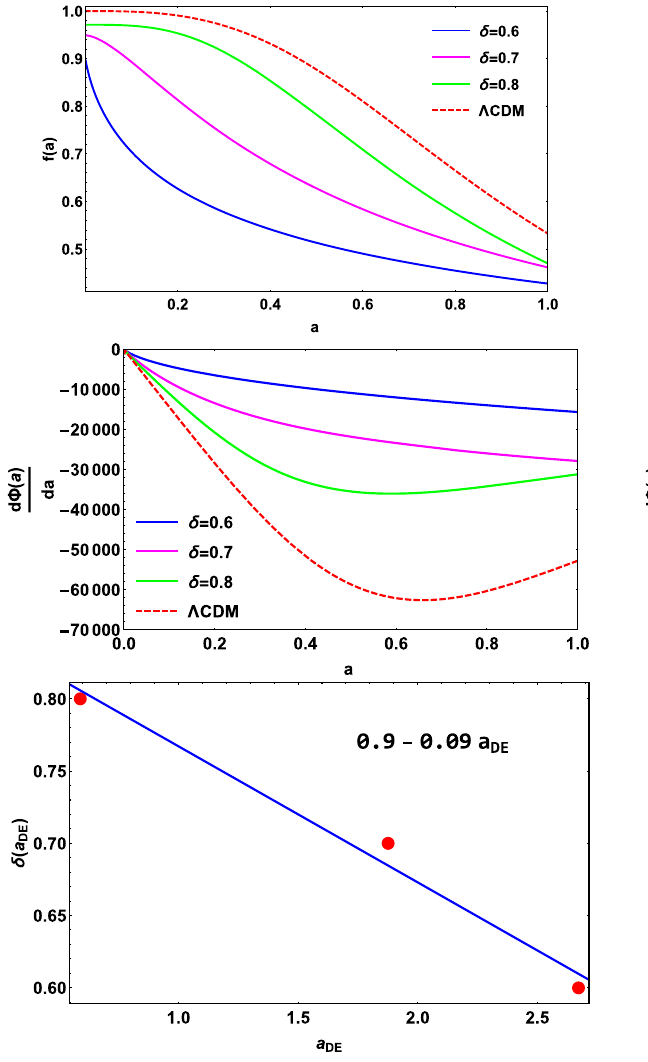
Fig. 4 Topleftpanelshowstheevolutionofgrowthrate f ( a ) ,topright panel shows the rate of change of configurational entropy ( d Φ( a ) ), and da the lower panel shows the best fit relation between the non-additivity parameter δ and the scale factor a DE at which d Φ( a ) attains a minima. da The plots are drawn keeping λ unity